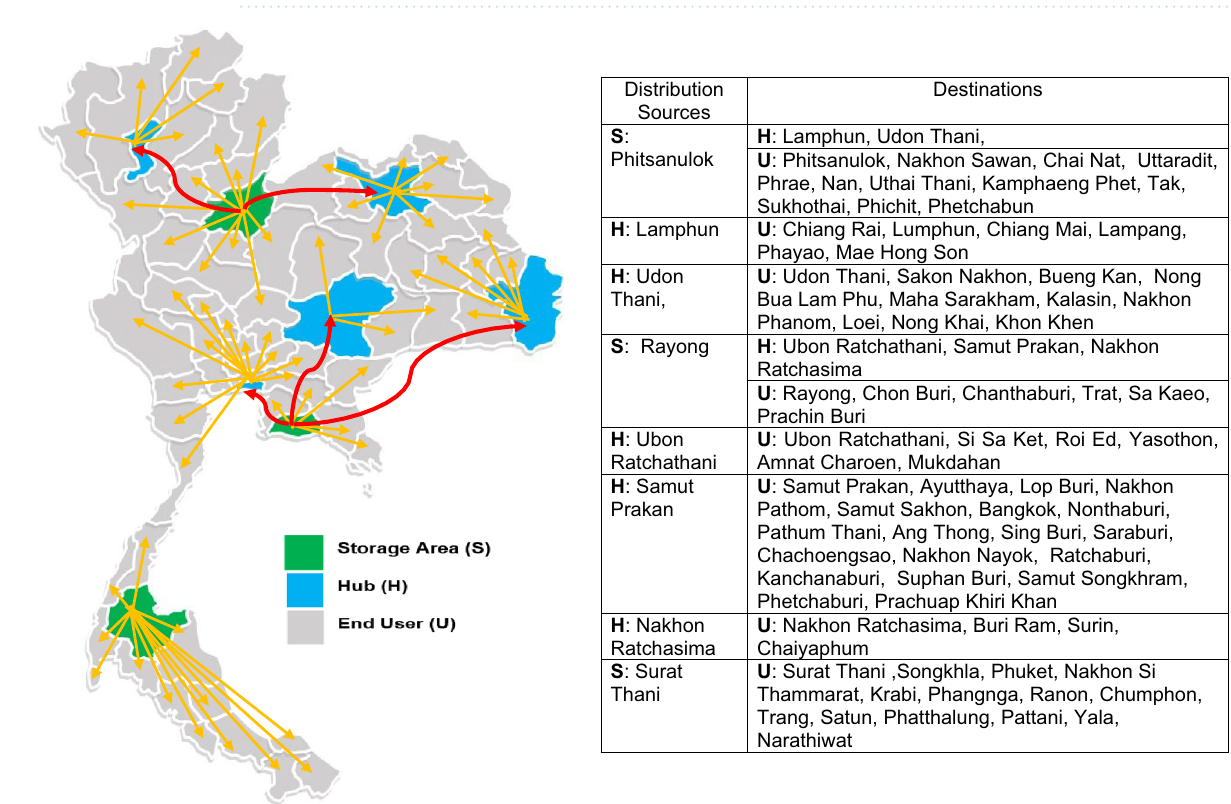
Figure 6. The location of facilities (storage areas or hubs) to their end users for scenario B on Thailand map created with Microsoft Office 365, Excel Version 1905 (https:// www. office. com/ launch/ excel? auth=2).